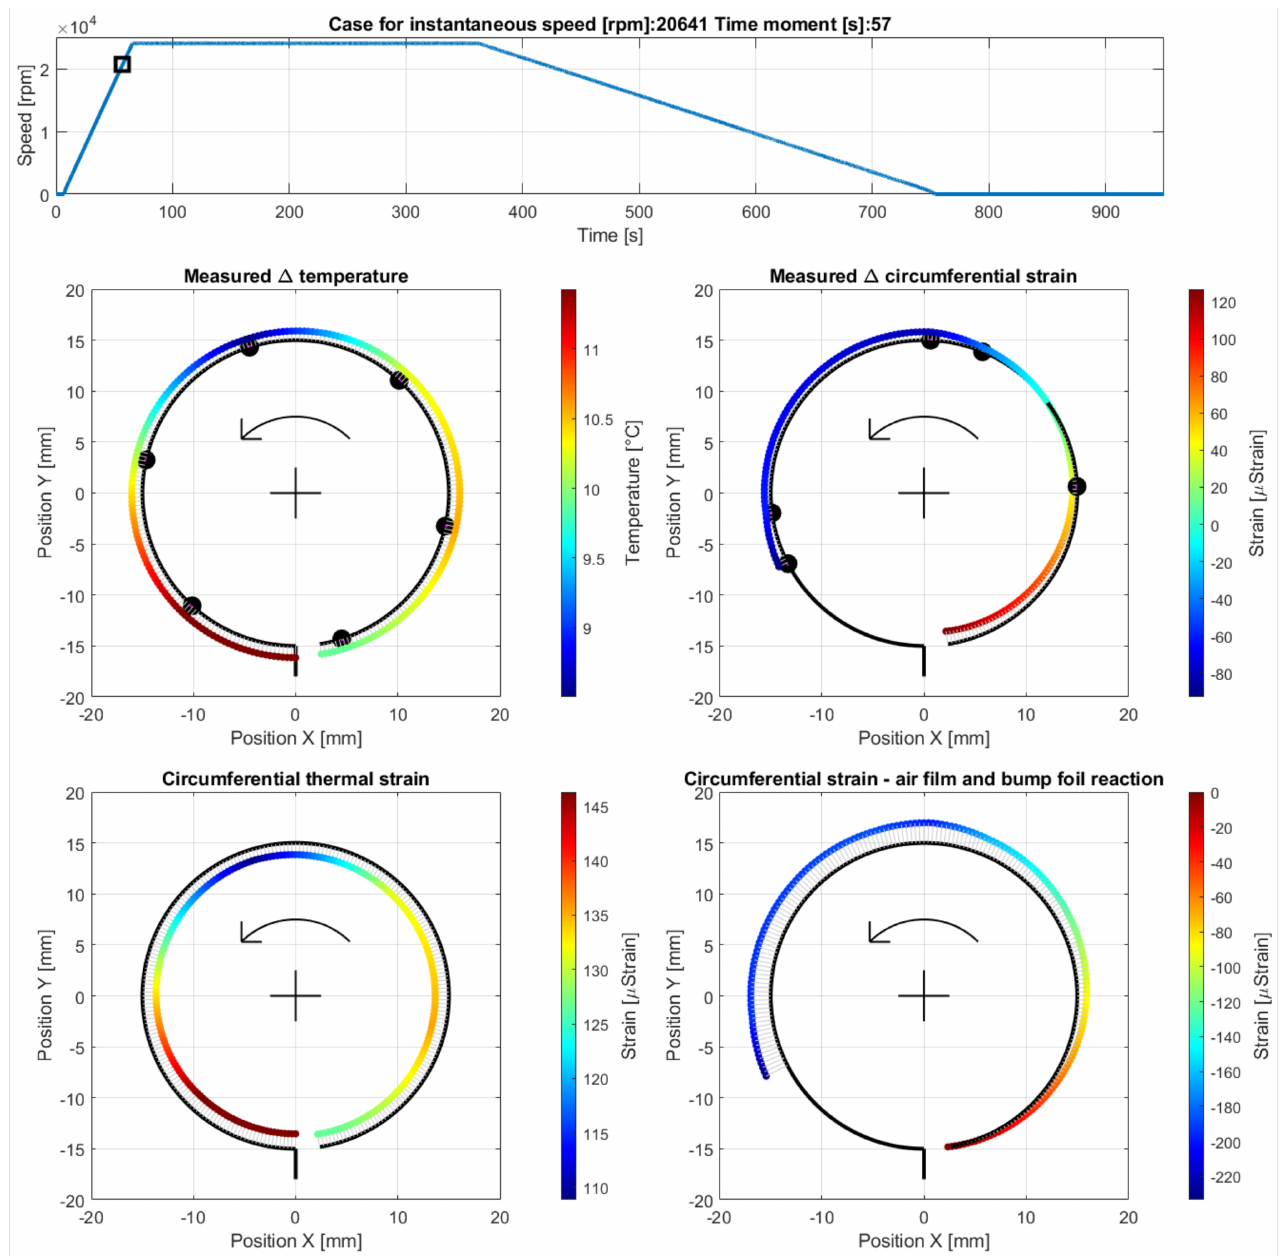
Figure 13. Cross-sectional views for the circumferential distribution of the temperature and strain identified in the top foil at 20,641 rpm during the run-up stage of the GFB’s operation after the homogenization of the